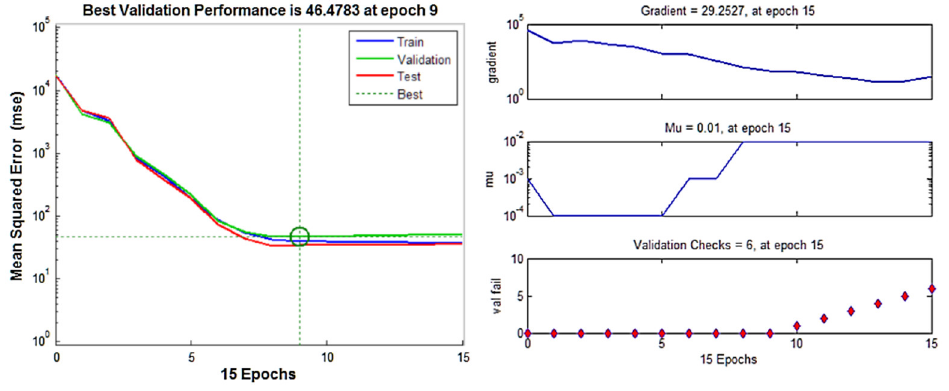
Figure 20. Training state and performance of the generated NN2 model for RCU.